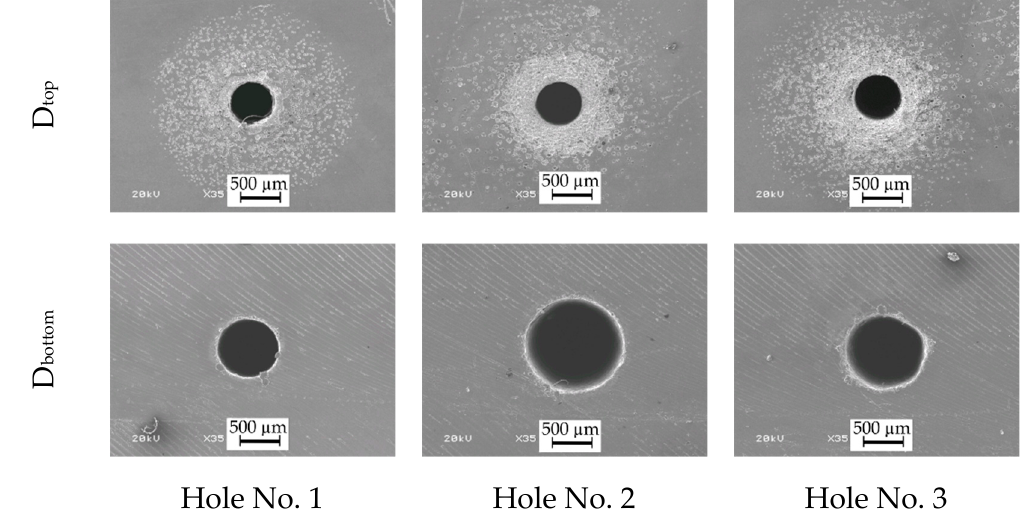
Figure 17. Through holes drilled in the Inconel 718